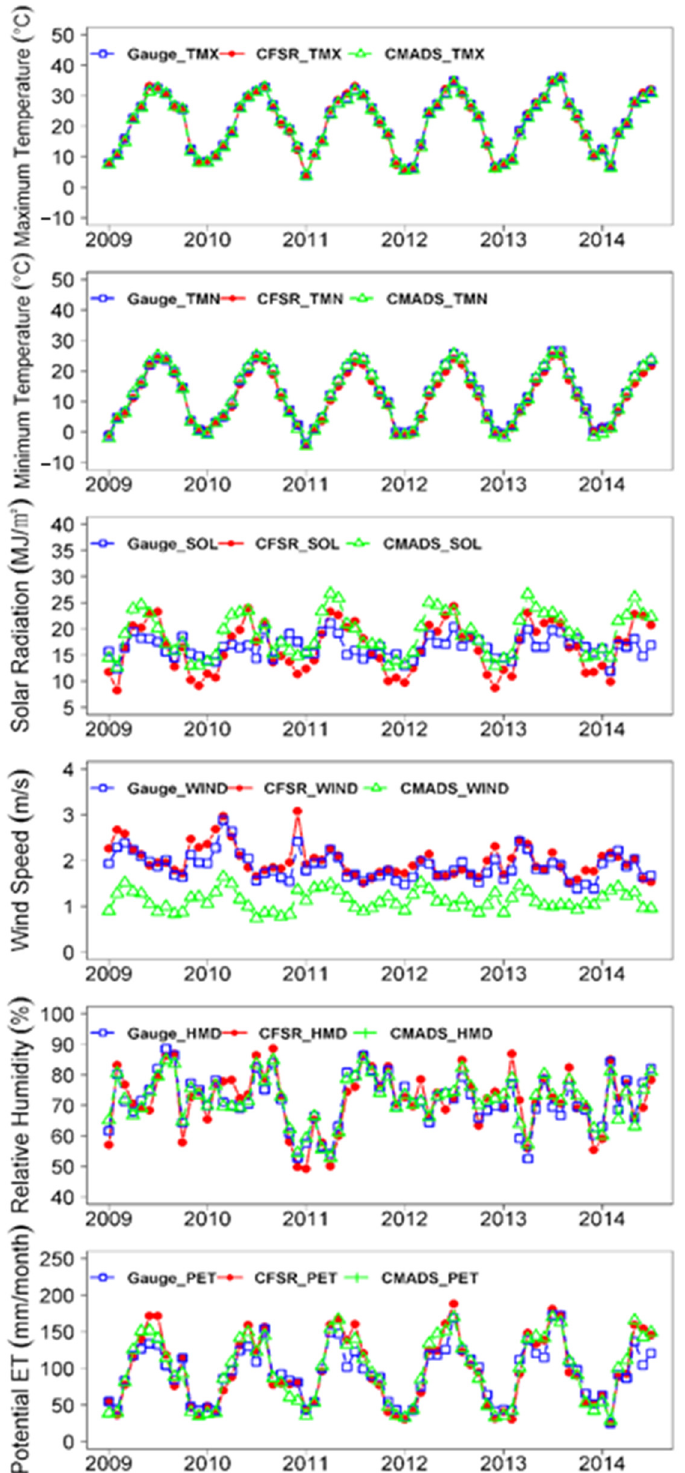
Figure 6. Comparison of the monthly mean of daily maximum (TMX) and minimum (TMN) air temperature, solar radiation (SOL), wind speed (WIND), and relative humidity (HMD) from the Gauge, CFSR, and CMADS datasets, and their resulting potential evapotranspiration (PET) estimates at the watershed scale during 2009–2014.